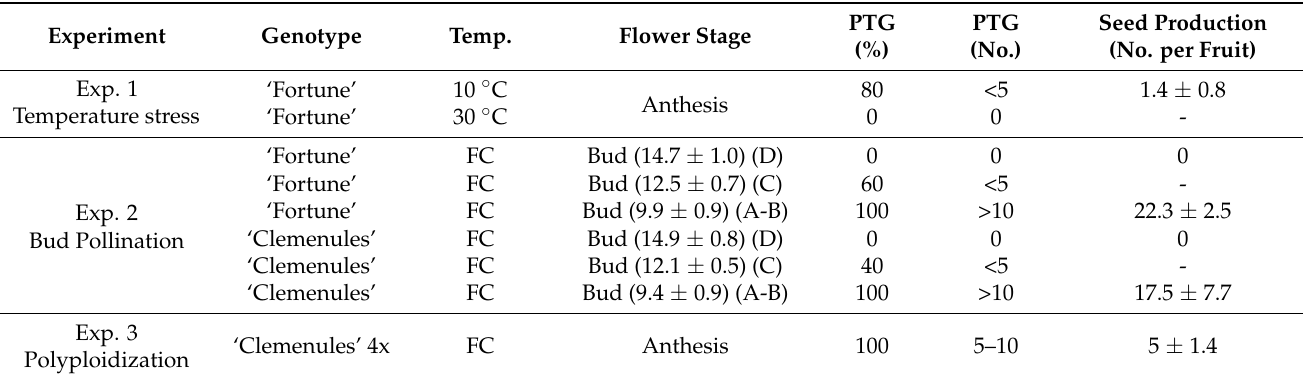
Table 1. Pollen tube growth (PTG) and seed production obtained from the self-pollinated flowers in each